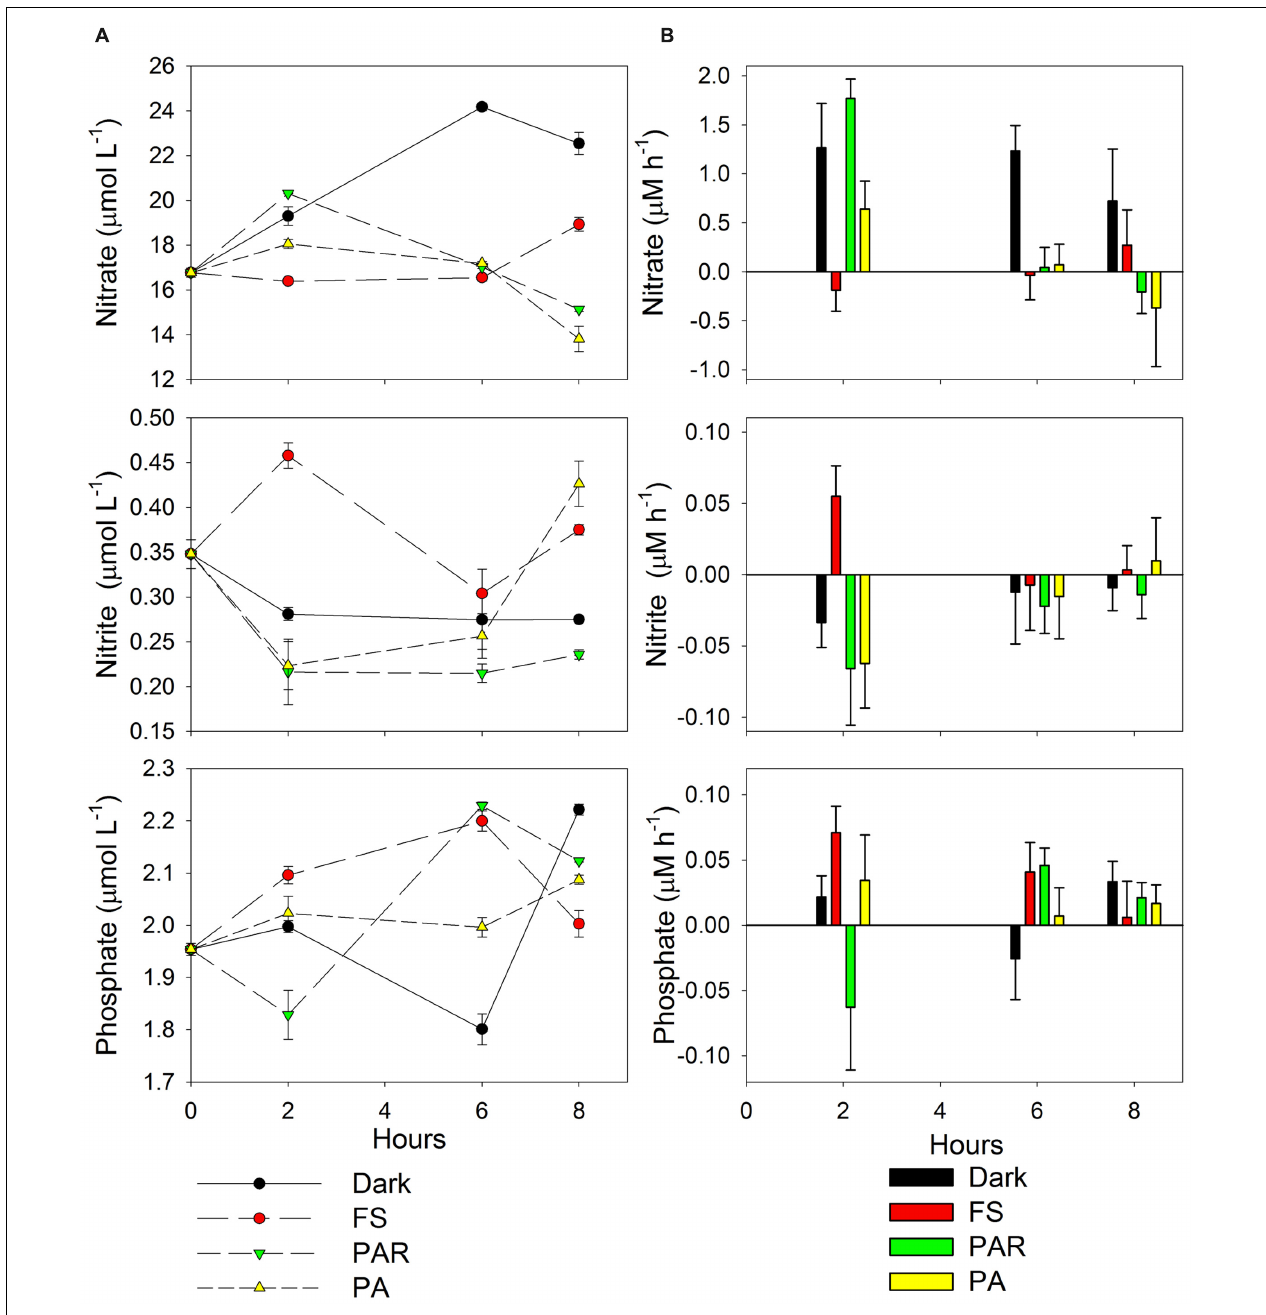
FIGURE 1 | (A) Nitrate, nitrite and phosphate variability through the incubation and treatments. (B) Changes in nutrient concentration through time ( µ M h − 1 ) obtained by end point determination approach. The rates were estimated from the different incubation treatments, considering the differences between the hours at 2, 6, and 8 h (11:30, 15:30, and 17:30 h) compared with in situ nutrient concentrations as initial time (9:30 h). Treatments acronyms: FS (full sun treatment between 280 nm–700 nm), Dark (cover by aluminum foil and black plastic bags), PAR (400–700 nm, Photosynthetically Active Radiation), and PA (320–700 nm, UVR and